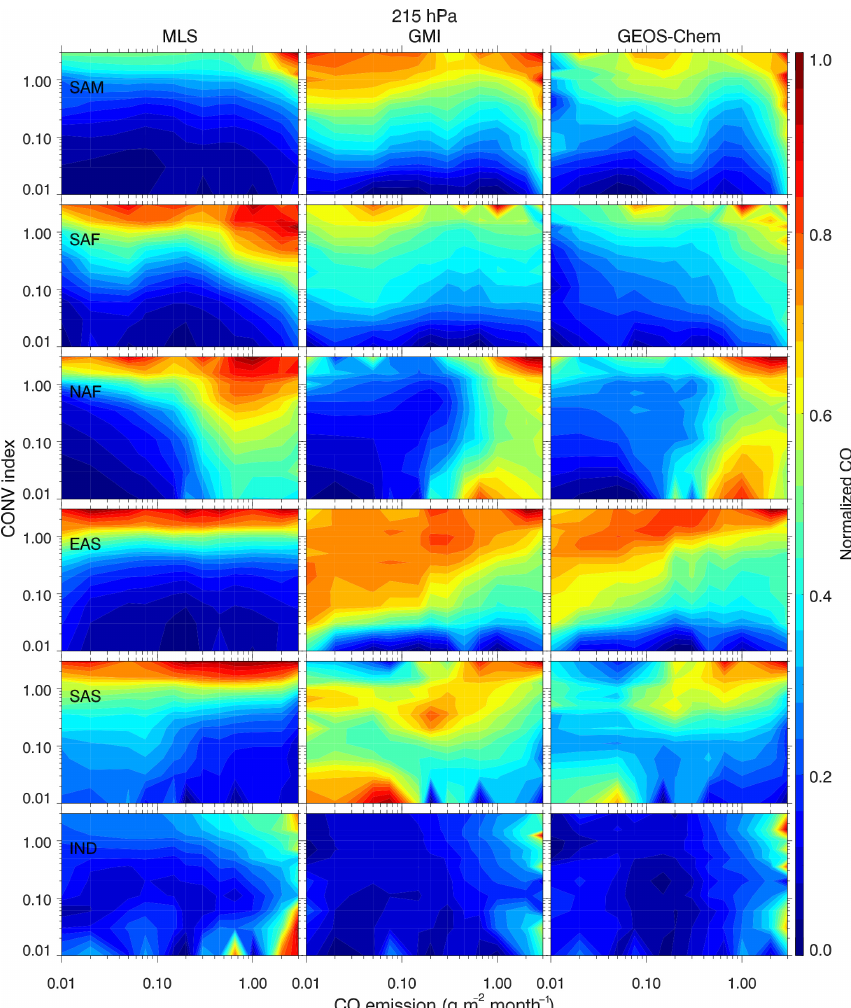
Figure 17. Contour plots of normalized CO mixing ratio at 215hPa over six regions: (top row) South America, (second row from top) southern Africa, (third row from top) northern Africa, (fourth row from top) East Asia, (fifth row from top) South Asia and (bottom row) Indonesia, from MLS observation (left column), GMI model simulation (middle column) and GEOS-Chem model simulation (left column) binned according to the surface CO emission ( x axis) and convective index ( y axis) at the same pressure level. See text for more